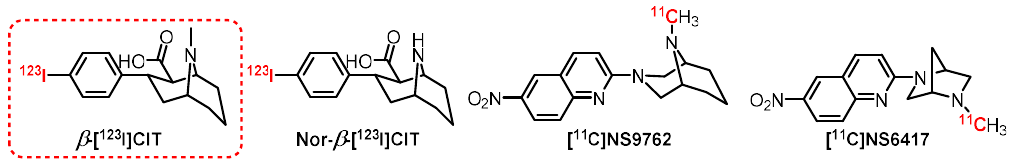
Figure 23. SERT tracer in the tropane series.